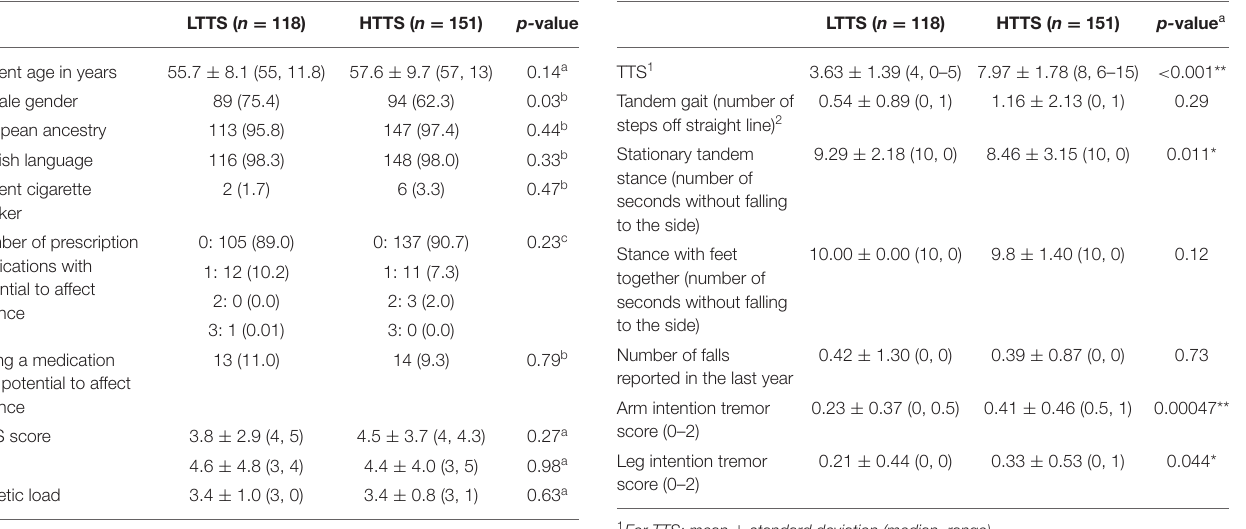
TABLE 1 | Demographic and clinical features of LTTS vs. HTTS. TABLE 2 | Signs of cerebellar function in LTTS vs.